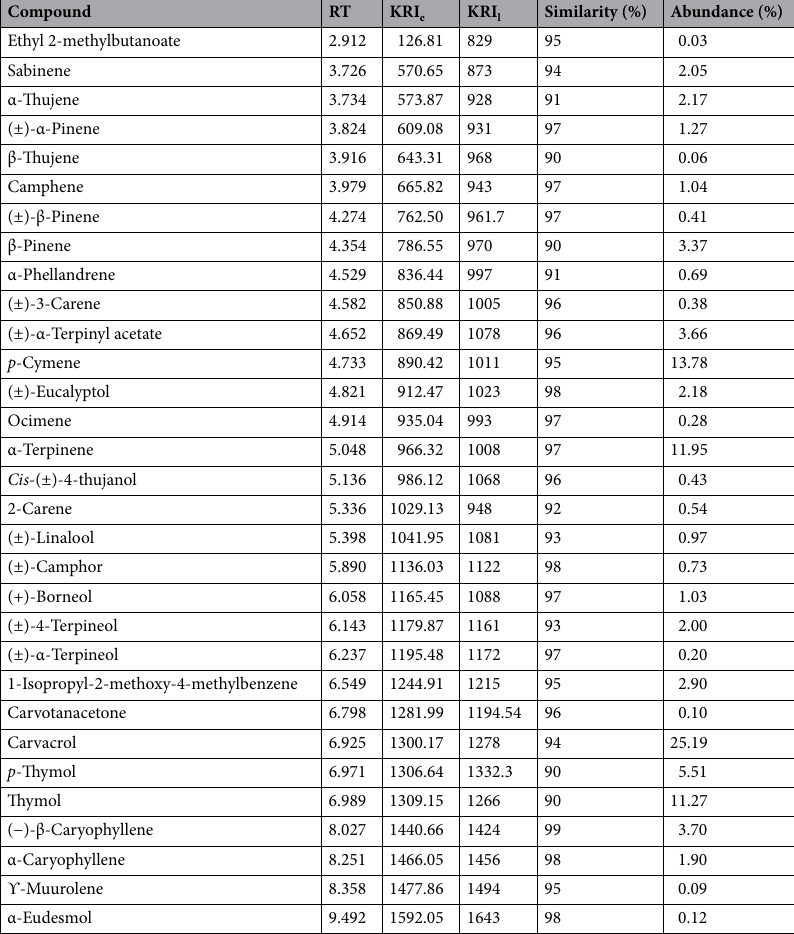
Table 2. Compounds present in the essential oil of Lippia graveolens identified by gas chromatography- mass spectrometry. RT retention time, KRIe Kovats Retention Index estimated (column used: 30 m × 0.25 mm × 0.25 µm; dead-time 2.0 min), KRIl Kovats Retention Index from literature (column used: 60 m × 0.22 mm × 0.25 µm). The KRIe values are different from those in the literature, but the